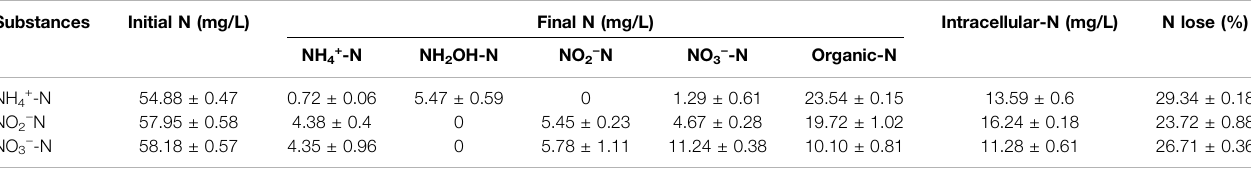
TABLE 1 | Nitrogen balances of ammonium, nitrite and nitrate removal by strain EM-A1.